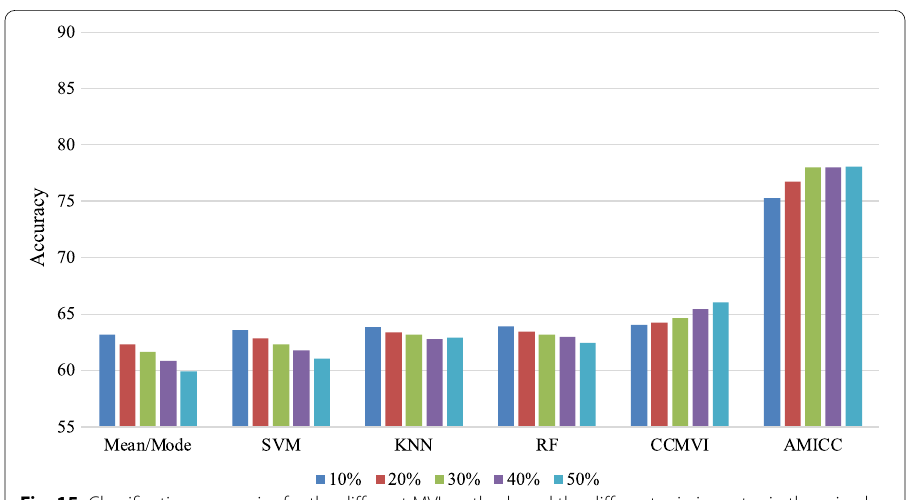
Fig. 15 Classification accuracies for the different MVI methods and the different missing rates in the mixed datasets